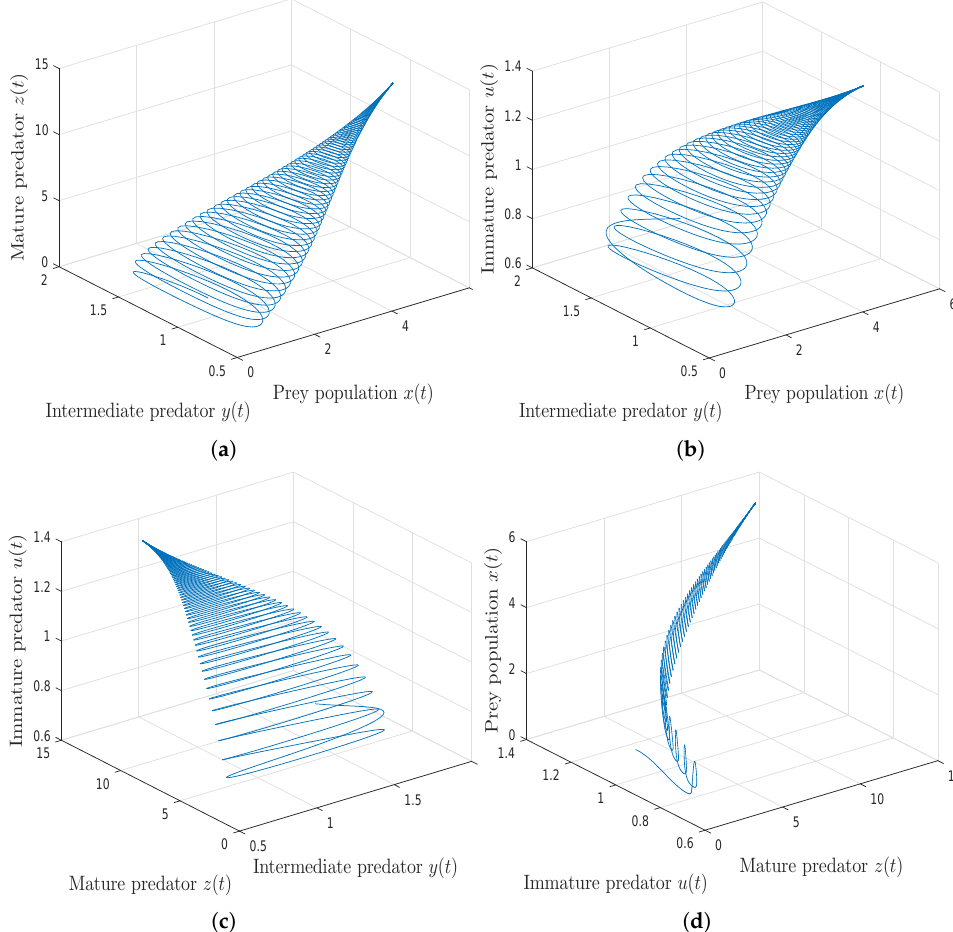
Figure 1. Three-dimensional phase plot for food web mathematical System (13) with generalized Caputo fractional operator when ϕ = 1 and ρ =